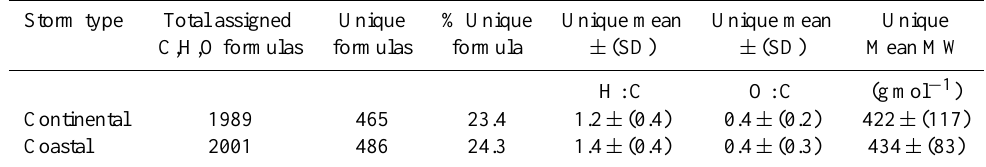
Table 1. Total assigned C,H,O formulas, unique formulas to each storm type and % unique of total assigned CHO formulas for the rain events analyzed during this study. Storm type Total assigned Unique % Unique Unique mean Unique mean Unique C,H,O formulas formulas formula ± (SD) ± (SD) Mean MW H:C